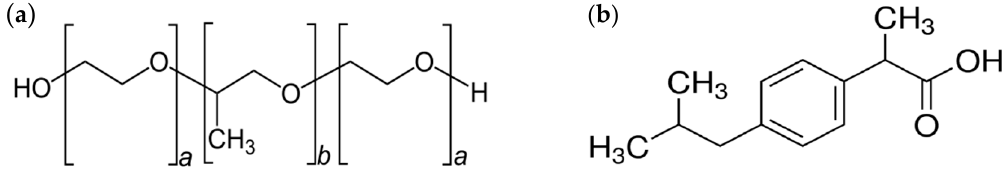
Figure 1. Molecular structures of ( a ) Pluronic and ( b ) Ibuprofen. Molecular weight of ibuprofen: 206.28 g/mol; solubility in water at 20 °C: 0.021 mg/mL [22]; partition coefficient (logP): 2.48 [23]; pKa: 5.38 at 25 °C [24].